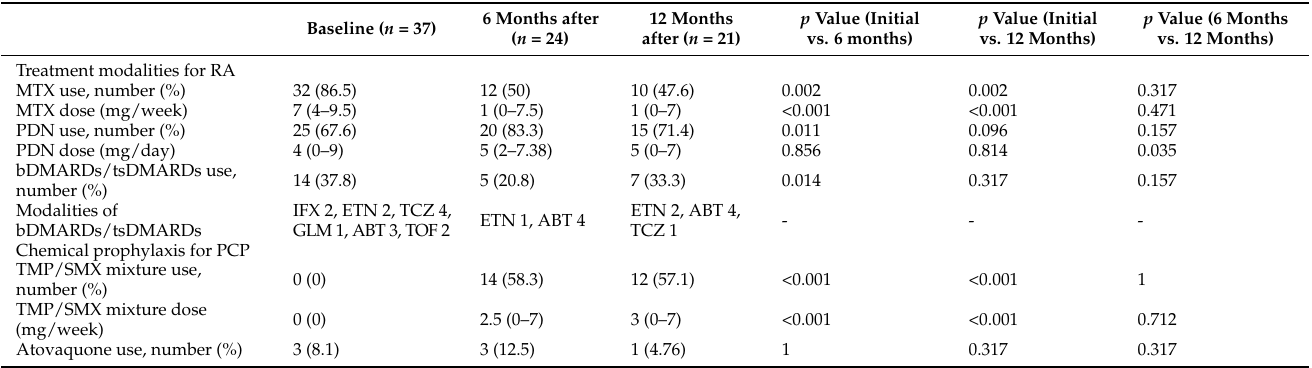
Table 5. Changes in treatment modalities for RA and chemical prophylaxis for PCP during the course after PCP